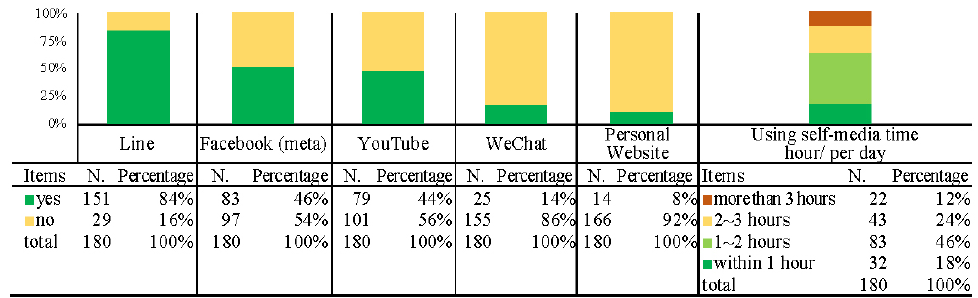
Figure 7. Descriptive statistical results for participants’ self-media use and frequency.